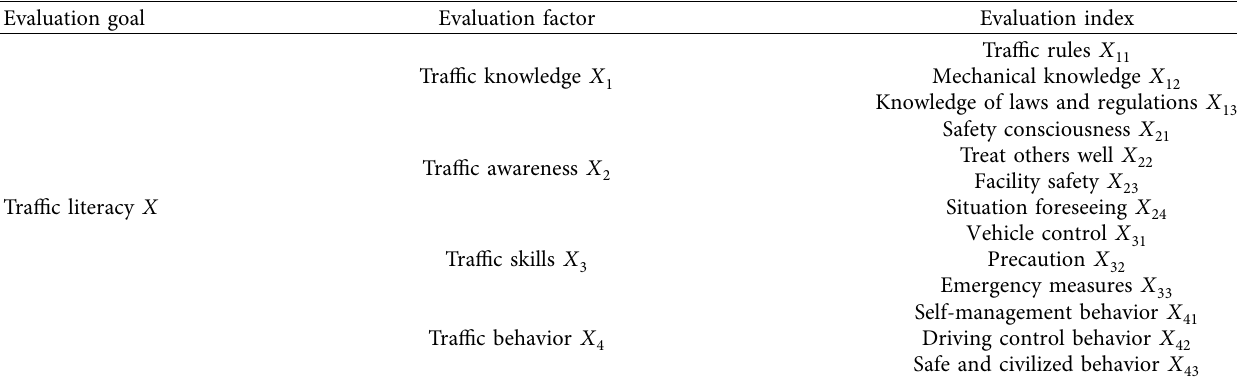
Table 1: Structure of traffic literacy evaluation